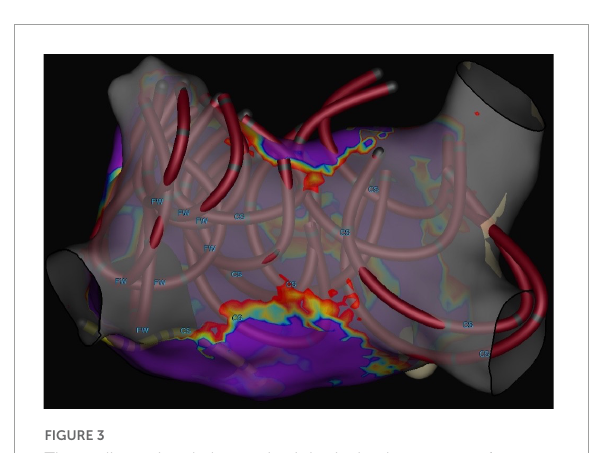
FIGURE3 Three-dimensional electrophysiological voltage maps after pulmonary vein isolation + posterior wall ablation performed with pulsed field ablation. The circular catheters show the locations where PFA was applied with a catheter in the flower